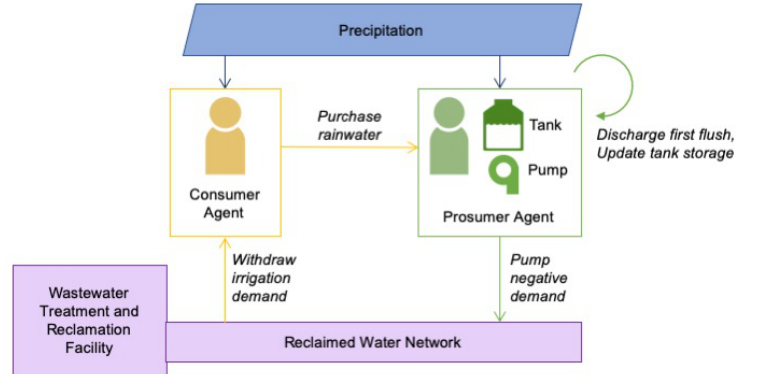
Figure 2. Agent-based modeling framework couples consumer and prosumer agents with a reclaimed water network. Image credit: Water Tank by Carlos Ochoa from the Noun Project.